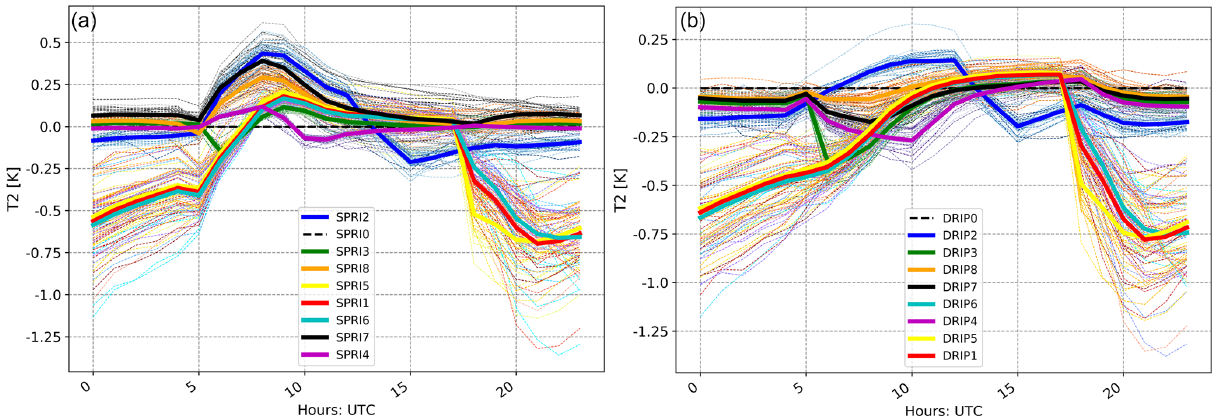
Figure 14. Same as Fig. 13a and b for the 2m height temperature differences and a different set of parameterizations for the SPRINKLER (option 3, a ) and DRlP (option 2, b